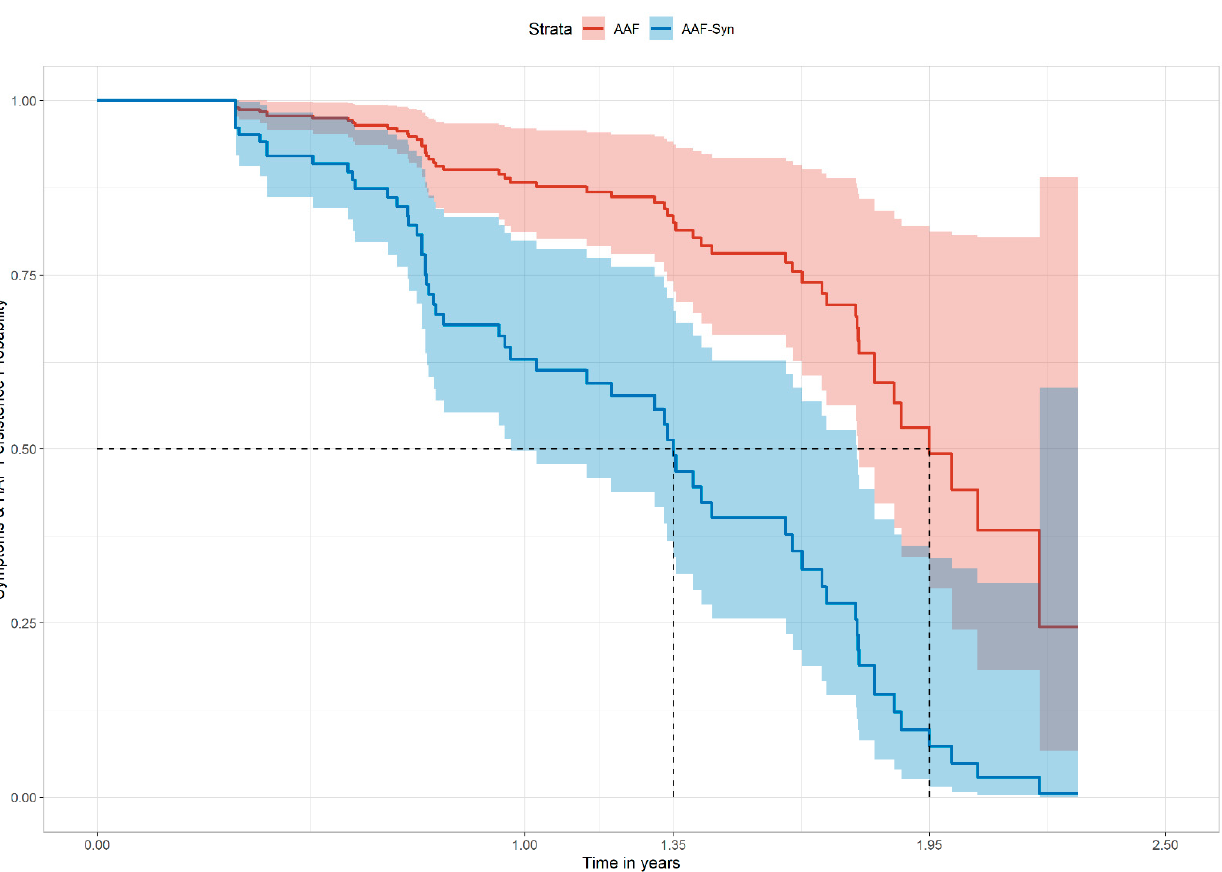
Figure 2. The adjusted Cox proportional hazard regression model showing the combined probability of symptom persistence and ongoing HAF prescription over time. Abbreviations: HAF: hypoallergenic formulae; AAF: amino acid formula; AAF-Syn: amino acid formula with synbiotics.